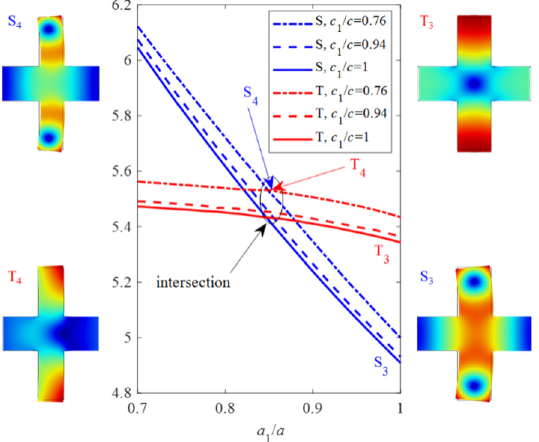
Figure 5. Frequency shifts of the 2nd and 3rd modes as a 1 varies, and the vibration shape at specific points.